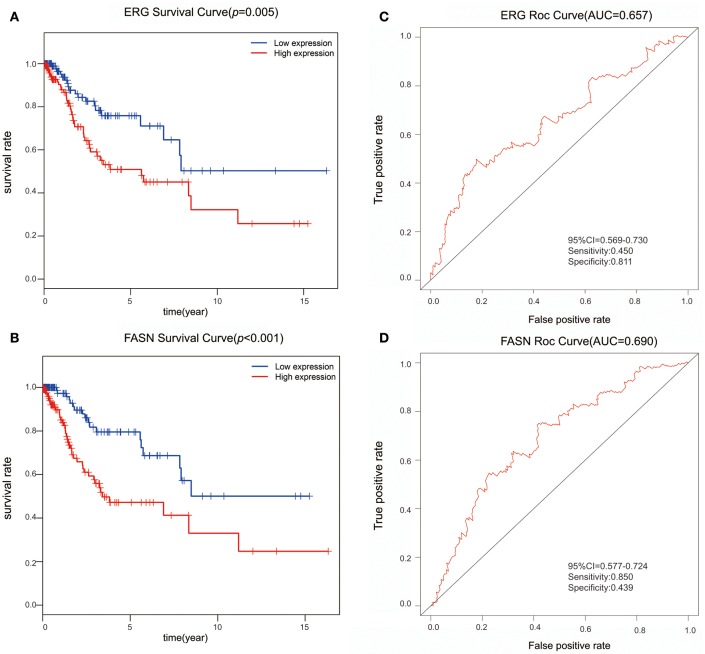
The predictive value of ERG and FASN on outcome. (A) The Kaplan-Meier survival analysis of ERG expression in overall survival. (B) The Kaplan-Meier survival analysis of FASN expression in overall survival. (C) ROC cure for predicting 3-year survival based on ERG expression levels. (D) ROC curve for predicting 3-year survival based on FASN expression level.